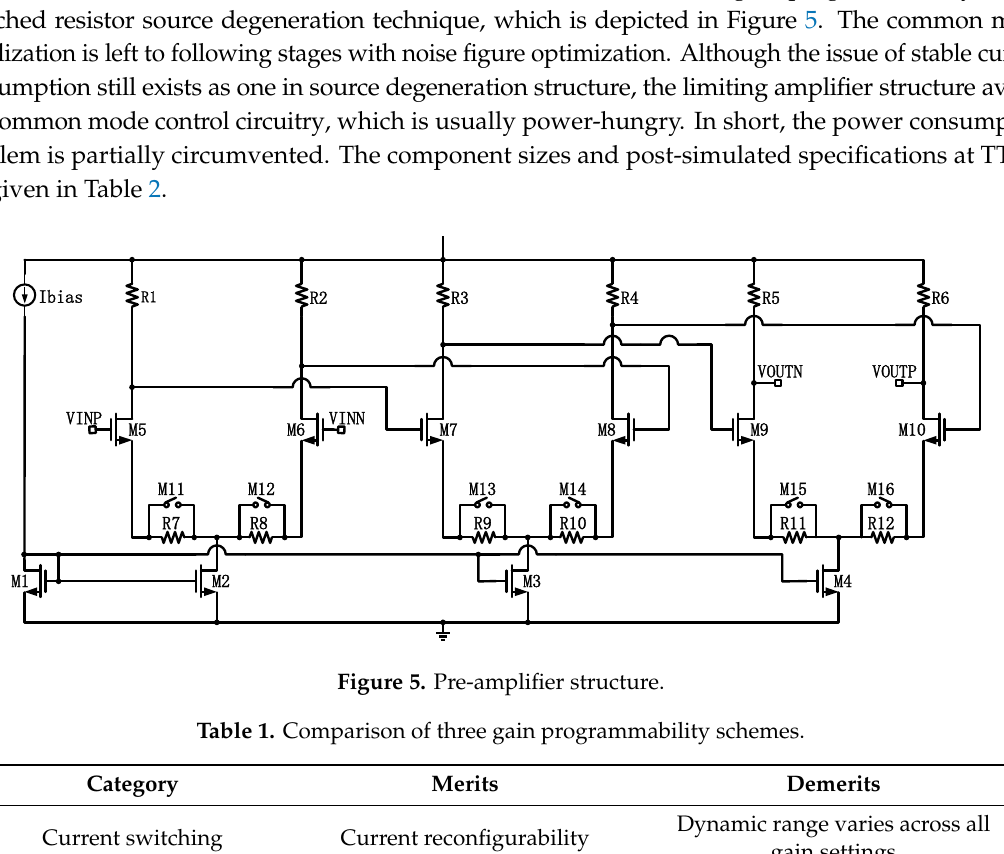
Figure 4. Typical architectures of analog baseband: ( a ) current switching topology; ( b ) load resistor switching topology; ( c ) source degeneration topology.